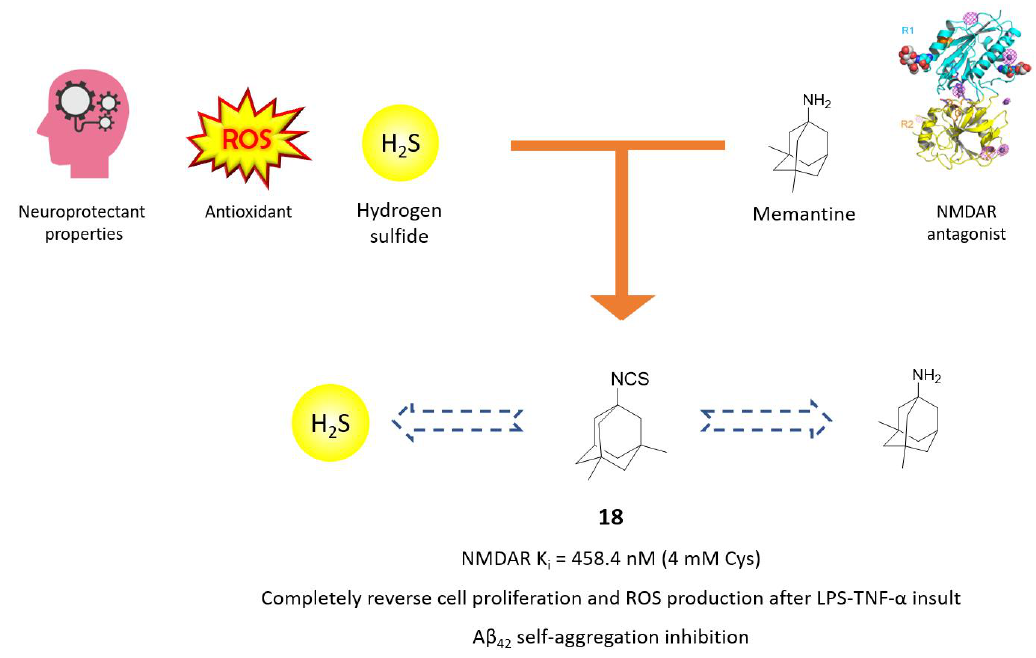
Figure 11. Drug design and biological activities of memantine prodrug 18 .